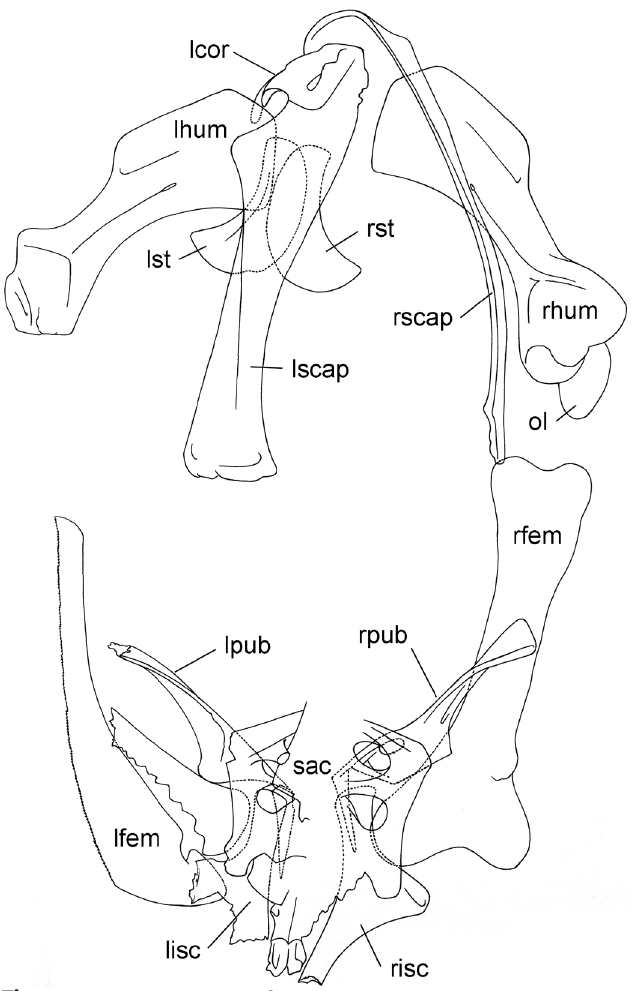
Figure 13. Specimen map for Vagaceratops irvinensis , CMN 41357, showing the relative position of limb elements. Adapted and simplified from a map prepared by D. Stoffregen.